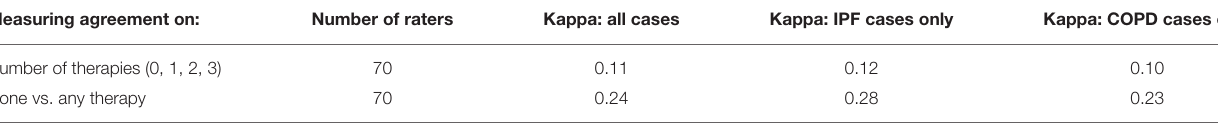
TABLE 3 | Fleiss’ Kappa calculations for US respondents who completed the entire survey ( n = 70).